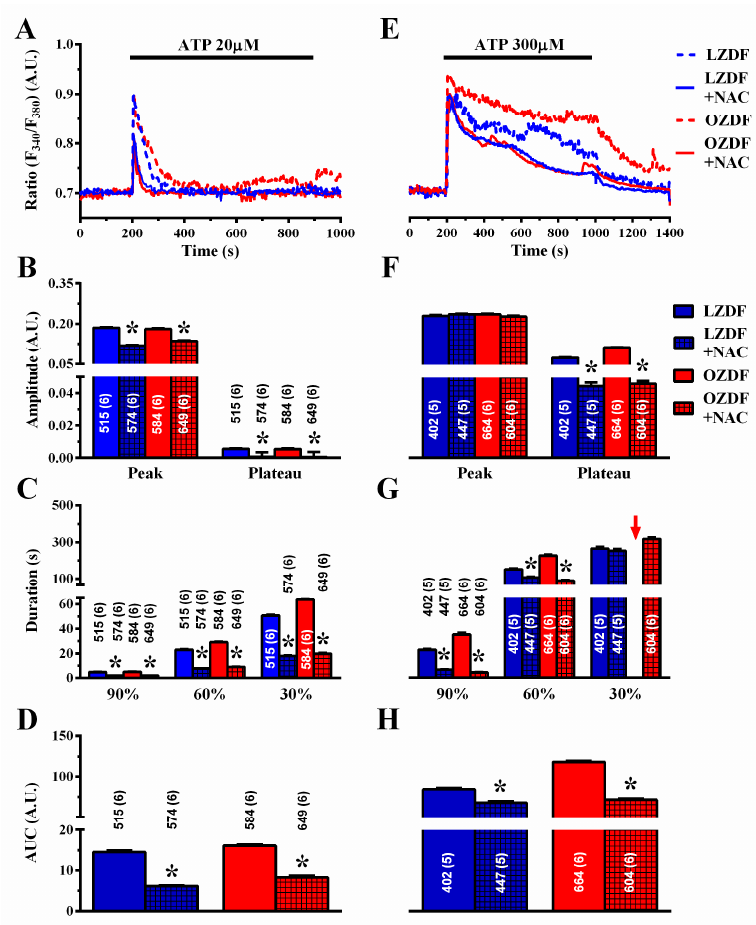
Figure 12. Scavenging ROS with NAC tempers the differences in the Ca 2+ response to ATP in obese Zucker diabetic fatty rats. ( A ) Representative recordings of the Ca 2+ response to 20 µM ATP in the absence or presence of 3 mM NAC in native aortic endothelium of LZDF and OZDF rats. Rat aortic rings were preincubated for 1 h with 3 mM NAC. ( B ) Mean ± SE of endogenous Ca 2+ release and SOCE amplitude recorded in native aortic endothelium of LZDF and OZDF rats challenged with 20 µM ATP in the absence or presence of 3 mM NAC. ( C ) Mean ± SE of the duration of the Ca 2+ response to 20 µM ATP recorded in native aortic endothelium of LZDF and OZDF rats in the absence or presence of 3 mM NAC. ( D ) Mean ± SE of the AUC of the two distinct components (i.e., endogenous Ca 2+ release and SOCE) of the Ca 2+ response to 20 µM ATP recorded in native aortic endothelium of LZDF and OZDF rats in the absence or presence of 3 mM µM NAC. ( E ) Representative recordings of the Ca 2+ response to 300 µM ATP in the absence or presence of 3 mM NAC in native aortic endothelium of LZDF and OZDF rats. ( F ) Mean ± SE of endogenous Ca 2+ release and SOCE amplitude recorded in native aortic endothelium of LZDF and OZDF rats challenged with 300 µM ATP in the absence or presence of 3 mM NAC. The asterisk indicates p < 0.05. ( G ) Mean ± SE of the duration of the two distinct components (i.e., endogenous Ca 2+ release and SOCE) of the Ca 2+ response to 300 µM ATP in native aortic endothelium of LZDF and OZDF rats in the absence or presence of 3 mM µM NAC. The asterisk indicates p < 0.05. Red arrows indicated that the Ca 2+ signal failed to reach the clearing rate indicated in the graph in OZDF rats. ( H ) Mean ± SE of the AUC of the two distinct components (i.e., endogenous Ca 2+ release and SOCE) of the Ca 2+ response to 300 µM ATP in native aortic endothelium of LZDF and OZDF rats in the absence or presence of 3 mM NAC. The asterisk indicates p < 0.05, Mann-Whitney test.